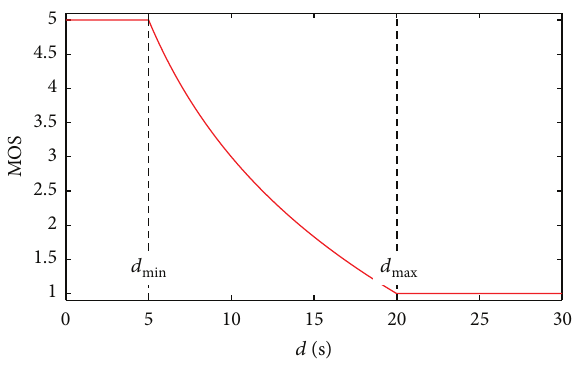
Figure 1: MOS versus